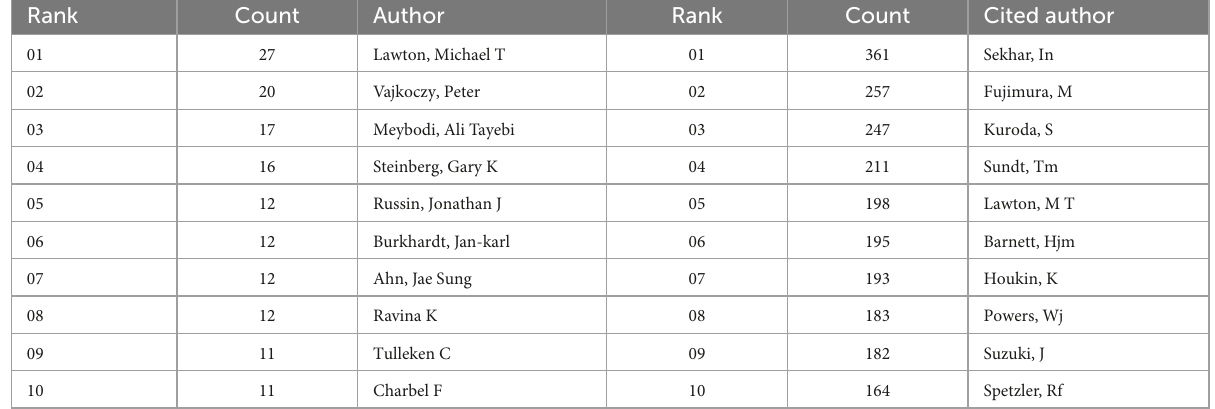
TABLE 4 Authors with the highest number of publications and citations (top